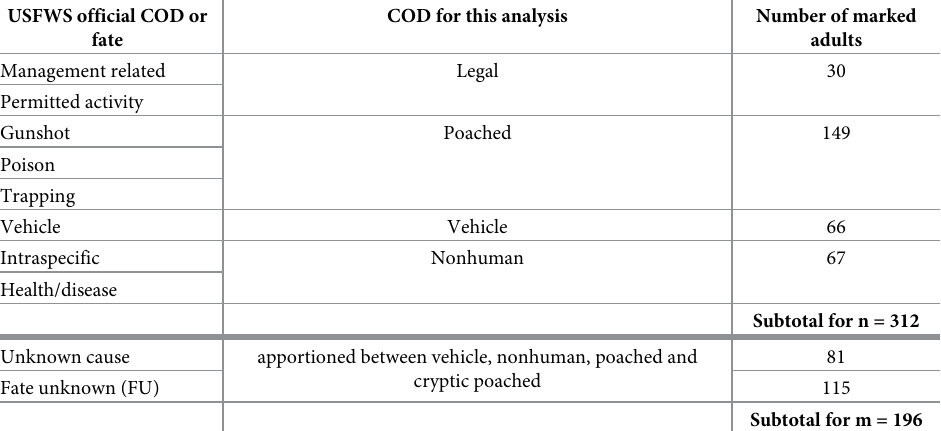
Table 2. Red wolf fates by our classifications, 1987–2018 for 508 radio-collared adults. The variable n (known fate subset) estimates the sum of known COD, and m (unknown subset) estimates the sum of FU and unknown COD. FU are those wolves who were radio-collared but were lost to USFWS monitoring. Legal COD was perfectly reported, all other CODs were